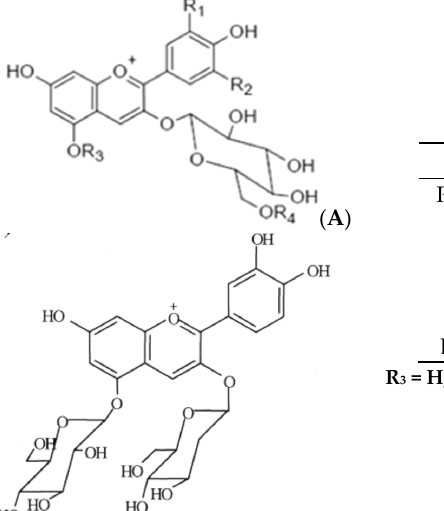
Figure 4. Anthocyanins structure found in Vitis vinifera ( A ) and in Vitis labrusca ( B ) red grape varieties.